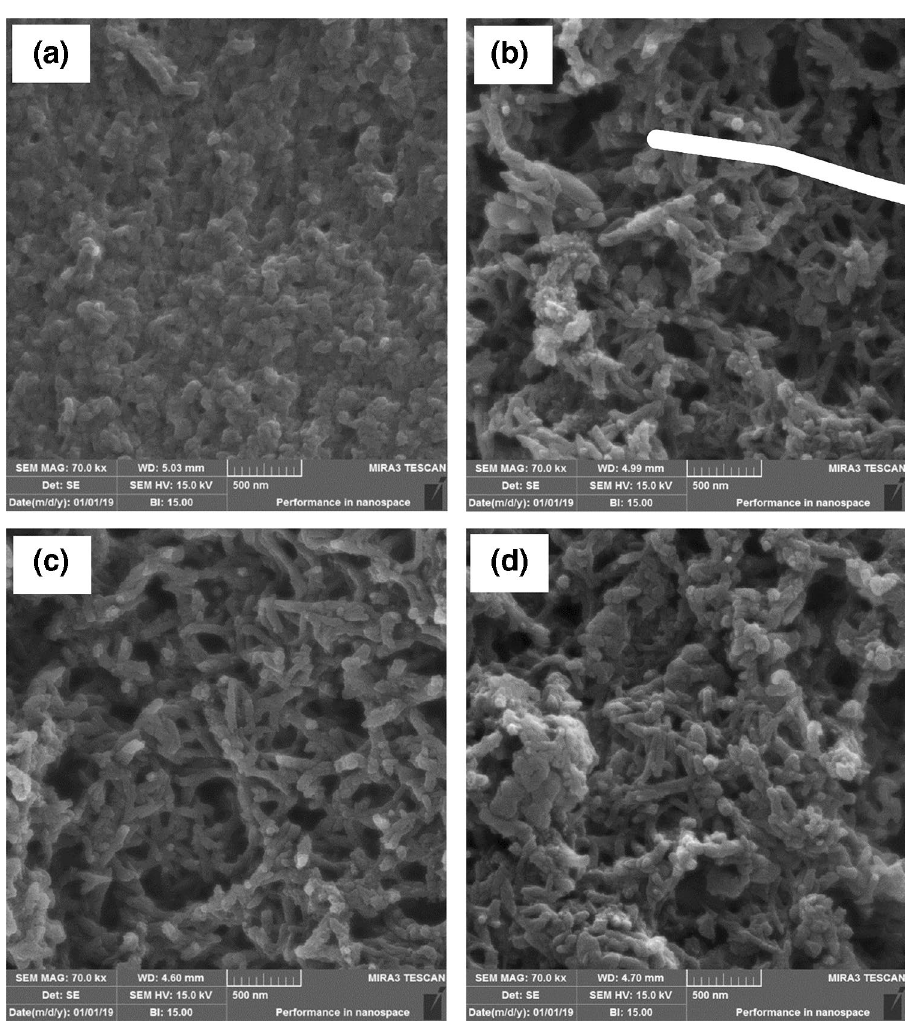
Fig. 5 FE-SEM images of the surface of PANI/GNS coated fabric, a 0.5 wt% GNS, at larger magnification, containing a 0.5 wt% GNS, b 2.5 wt% GNS, c 5 wt% GNS and d 10 wt%